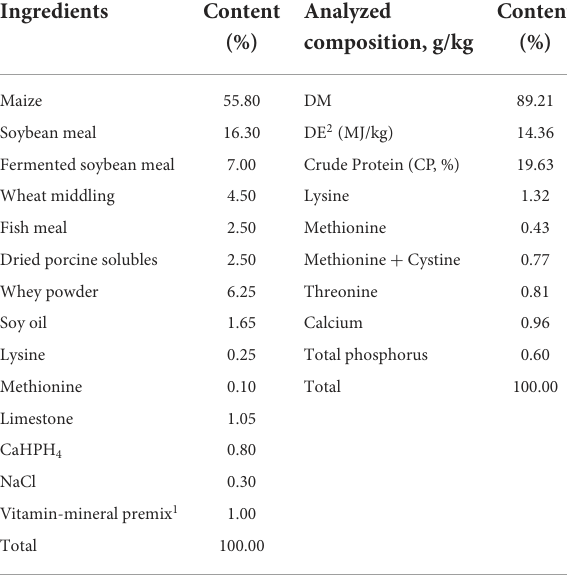
TABLE 1 Composition and nutrient levels of basal diet (air-dry